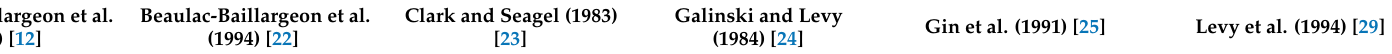
Absorption Related Parameters